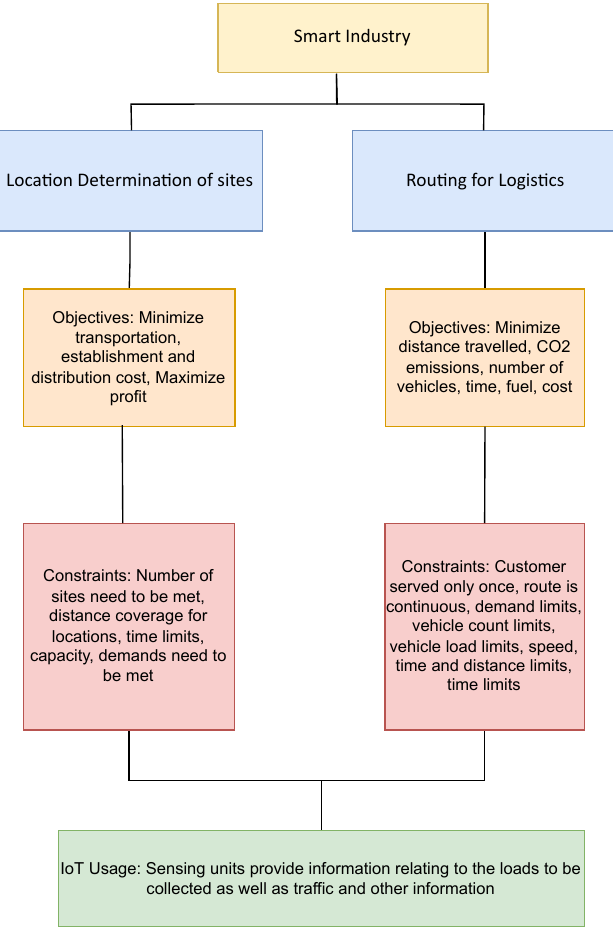
Figure 6. Optimization applications in Smart